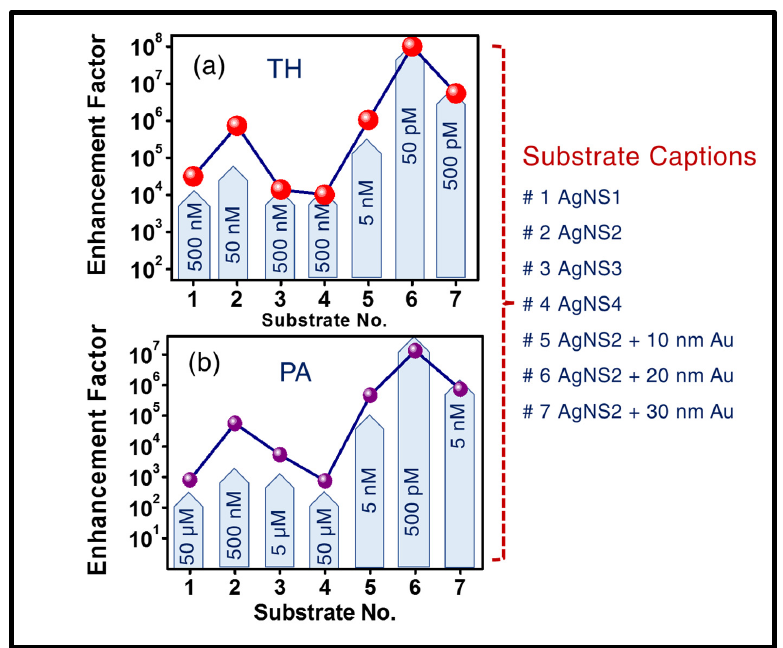
Figure 6. Enhancement factor comparison from the sensing performances of ( a ) TH ( b ) PA. These studies involved all the Ag NSs along with different thickness of Au coated AgNSs. Lowest detection limits (displayed in light blue colour) and enhancement factors (displayed as solid symbols; lines are only a guide to the eye) of each substrate are presented. ‘#’ refers to the sample number. Table 1. Summary of the estimated AEFs for various analyte molecules involving all the substrates